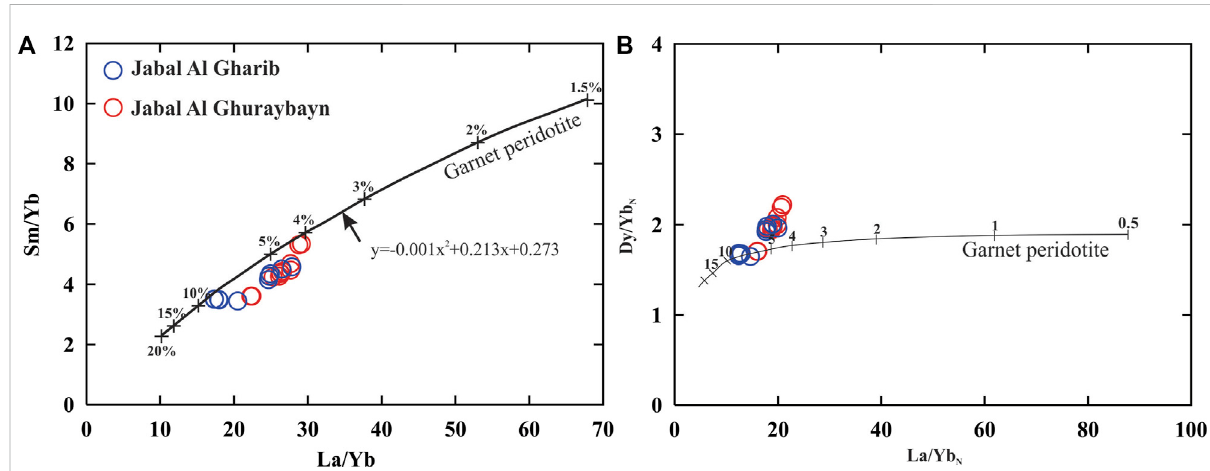
FIGURE 9 (A) Sm/Yb vs. La/Yb diagram showing batch melting curve calculated for garnet peridotite (for details, we refer to Zeng et al. (2010)). (B) La/Yb N vs. Dy/Yb N diagram showing non-modal batch melting curve calculated for garnet peridotite (for details, we refer to Ba ğ ci et al.